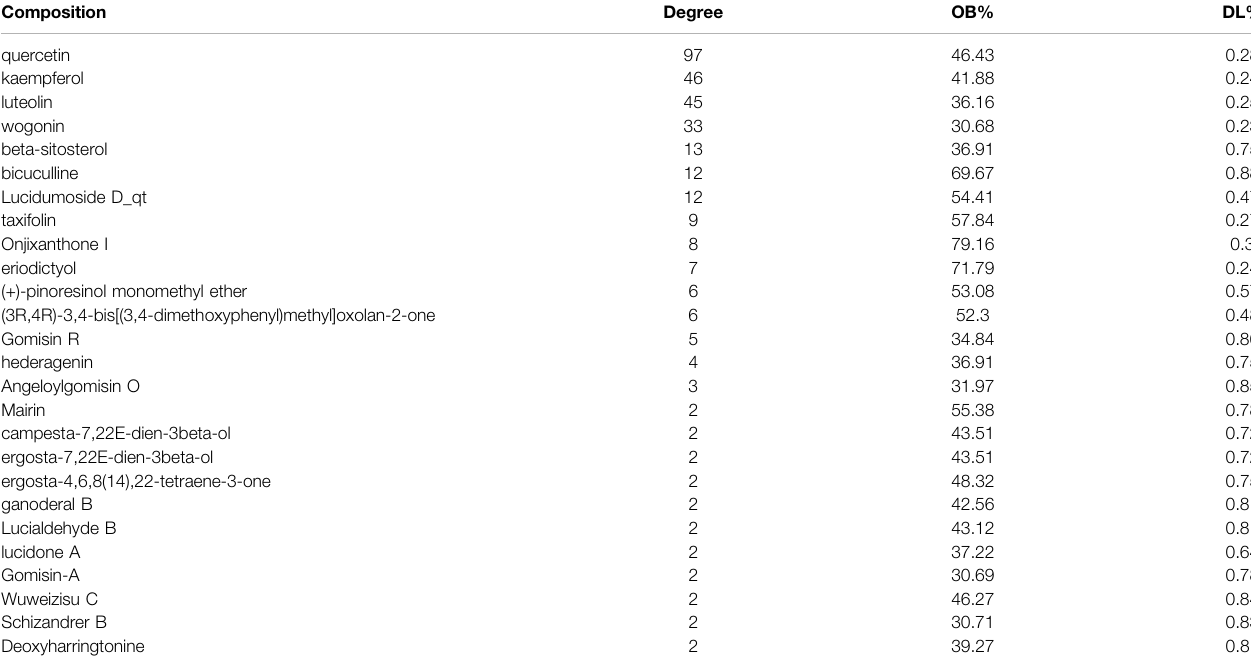
TABLE 1 | Prediction of anti-HBV components of LWWL based on network pharmacology.